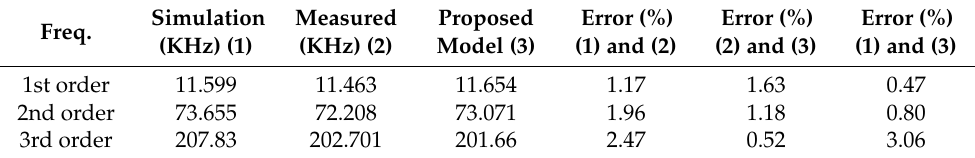
Table 3. Comparison of theory, simulation and measurement of resonance frequency.